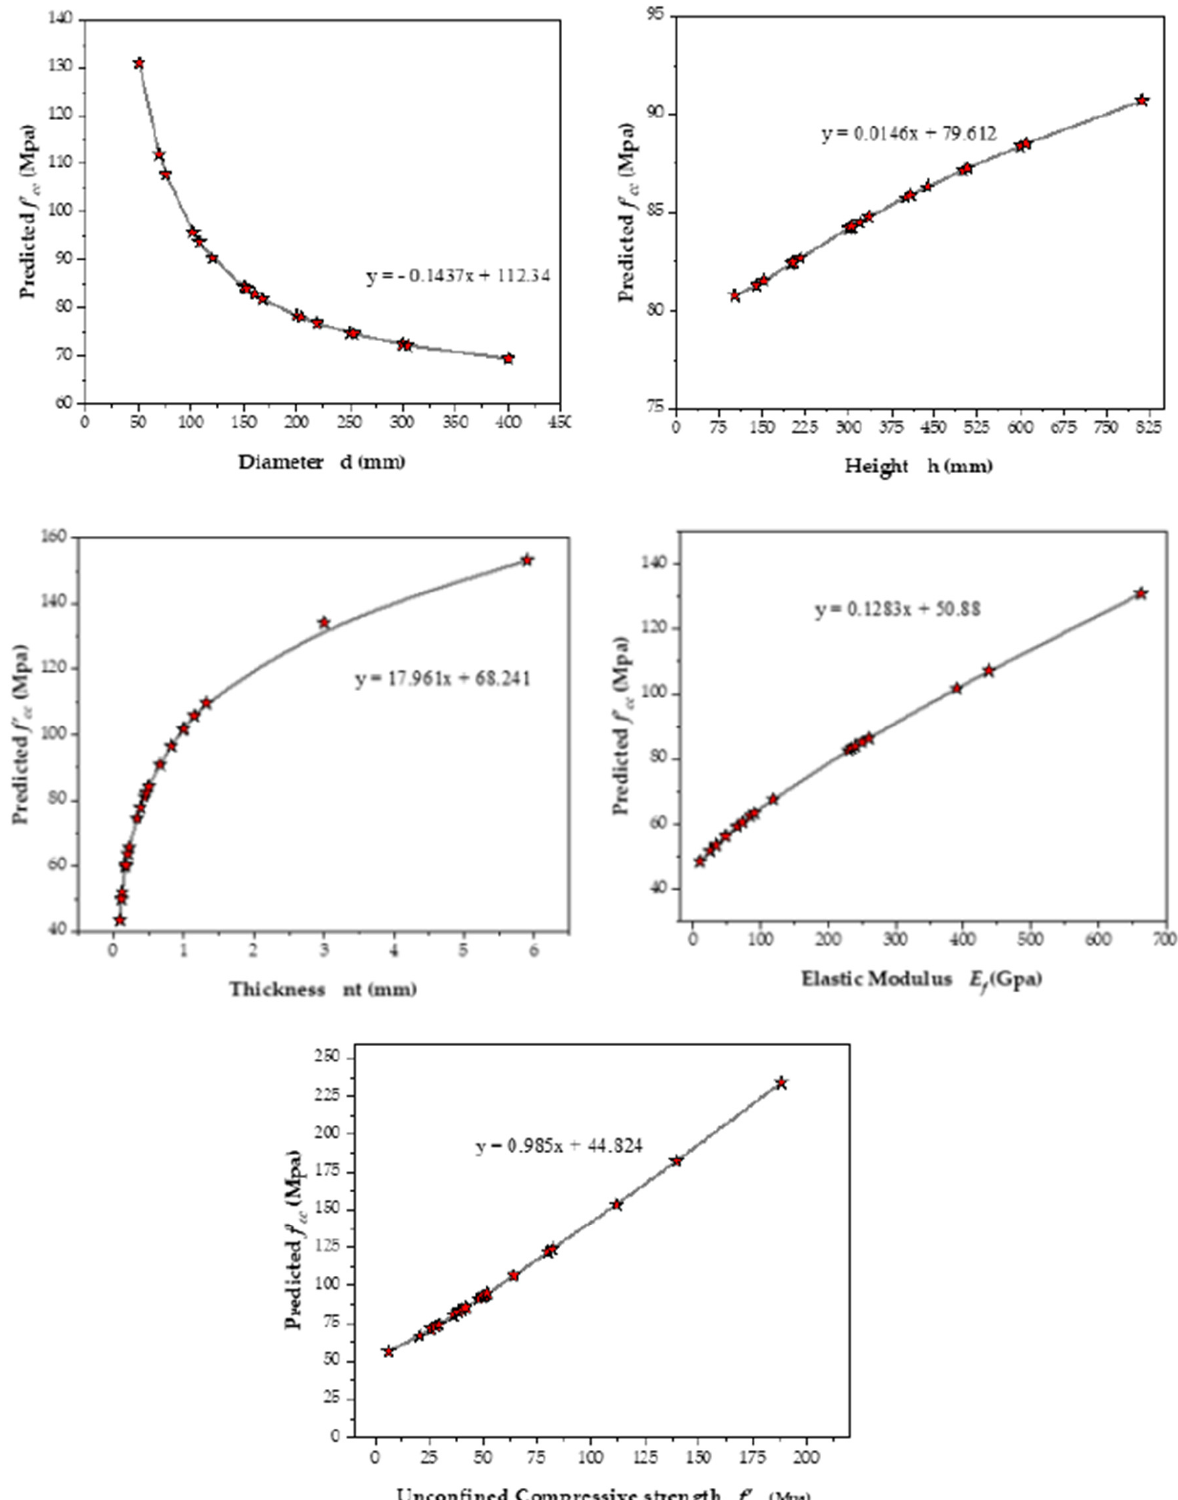
Figure 7. Parametric analysis of input